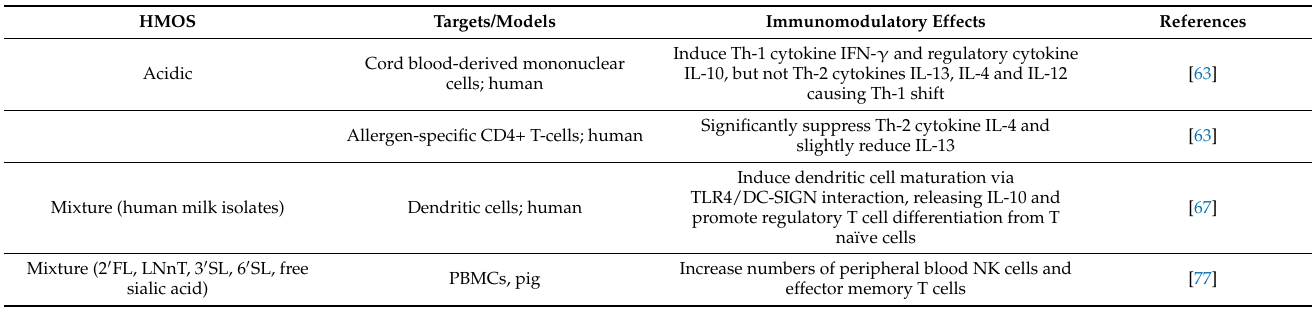
Table 2. Evidence supporting the immunomodulatory roles of